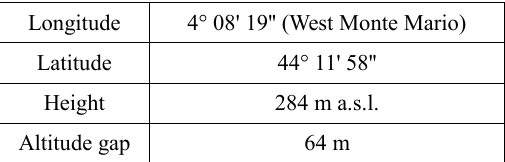
Table 1. Main characteristics of Pollera cave (longitude and latitude are in Roma40 Datum).